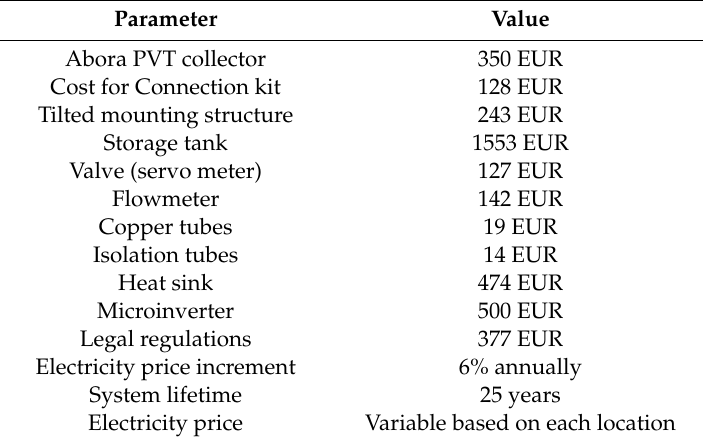
Table 4. Parameters considered for economic